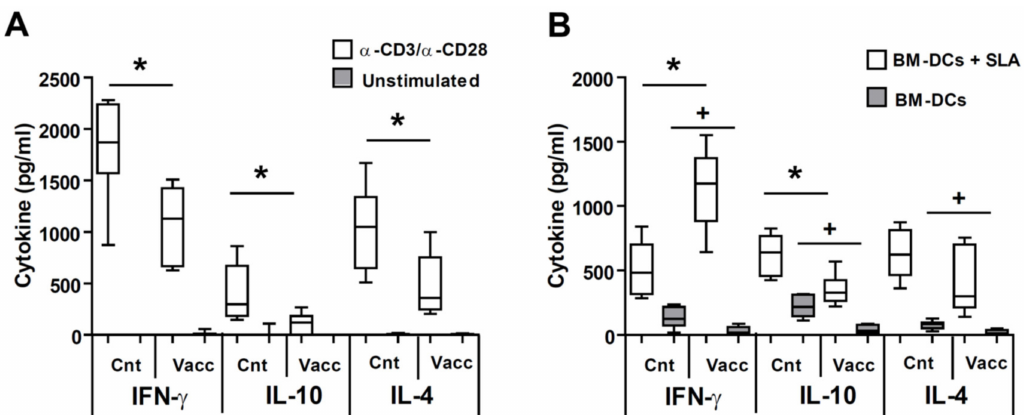
Figure 4. Analyses of the production of cytokines in the lymph node draining the site of L. amazonensis challenge. BALB/c mice were inoculated with PBS (control) or with 1 × 10 7 Li ∆ HSP70-II attenuated promastigotes suspended in PBS (vac- cinated) in the right footpad. At week 12 after vaccination control and vaccinated mice were challenged with 5 × 10 6 stationary L. amazonensis promastigotes in the left footpad ( n = 8). Animals were sacrificed at week 11 and the left popliteal lymph node cells were cultured in 96-well plates coated with anti-CD3 in complete medium supplemented with anti-CD28. As a control, similar cultures were performed in the absence of stimulating antibodies ( A ). Equivalent cultures were established and grown with BM-DCs loaded or not with SLA ( B ). The presence of IFN- γ , IL-10, and IL-4 was determined by ELISA in culture supernatants. Data are shown as whisker (min to max) plots. * ( p < 0.05; BM-DCs + SLA) or + ( p < 0.051; BM-DCs) shows the statistical differences between control and vaccinated groups (Mann–Whitney test). Results from one out of two similar experiments are represented.